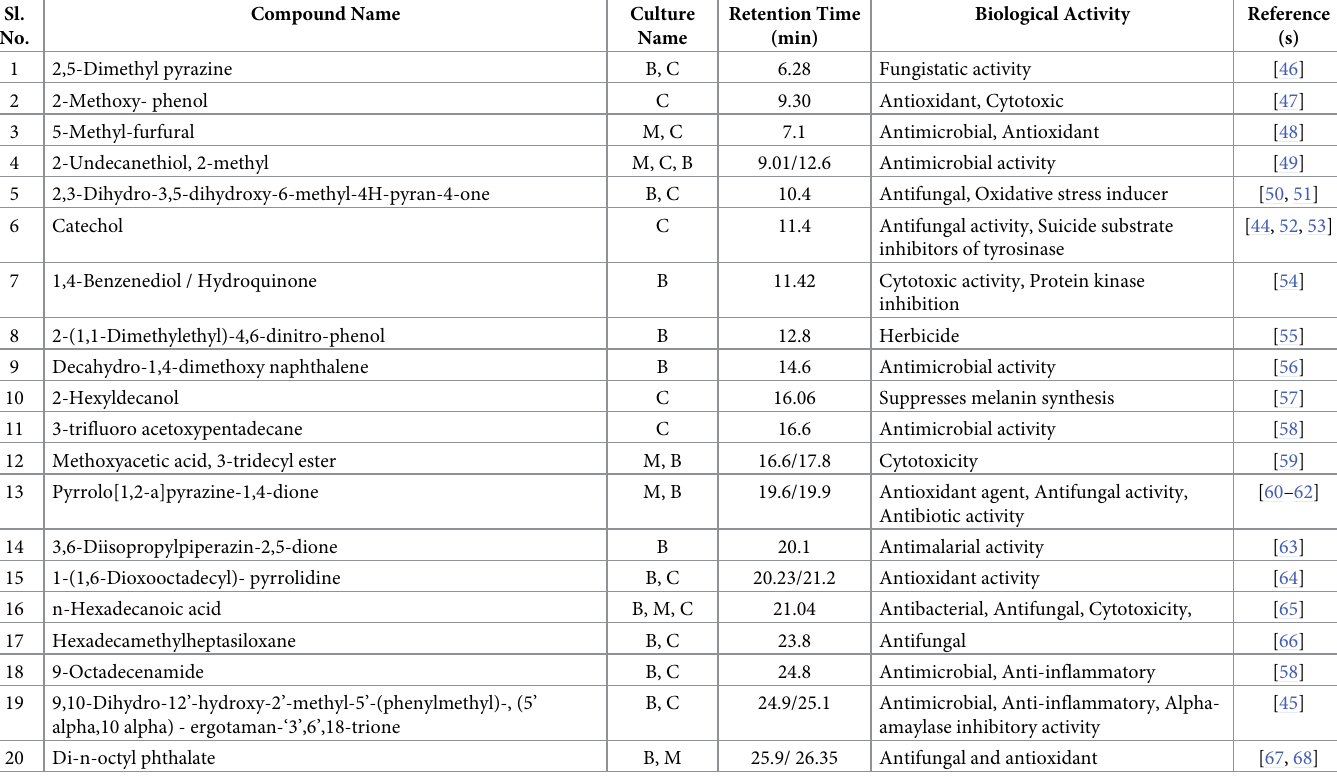
Table 4. List of potential compounds with their biological activities and retention times found in GC-MS analysis of B . contaminans NZ (B), M . phaseolina (M), and their co-culture (C). Sl.